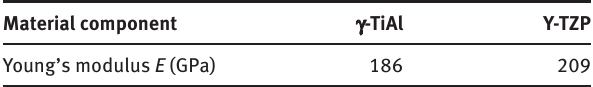
Figure 3: Square FGM plane structure. Table 1: The true values of the material